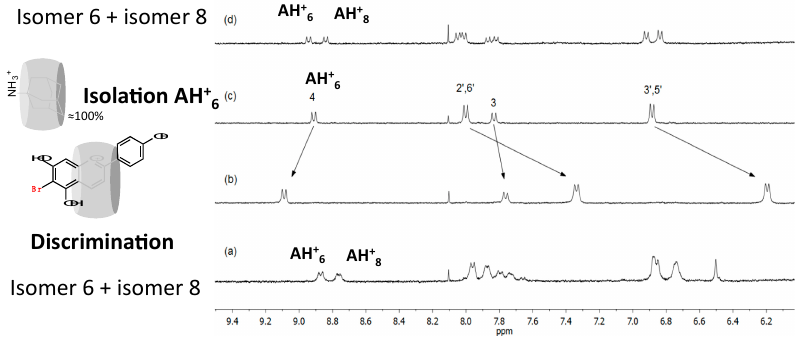
Figure 9. 1 H-NMR spectra of the compound 6-bromo apigeninidin and its isomer 8 ( a ) at the equilibrium pH = 1.0; ( b ) at the equilibrium after addition of cucurbit[7]uril; ( c ) immediately after addition of 1-aminoadamantane (AD) ( d ) Equilibration of ( c ) which is coincident with ( a ).